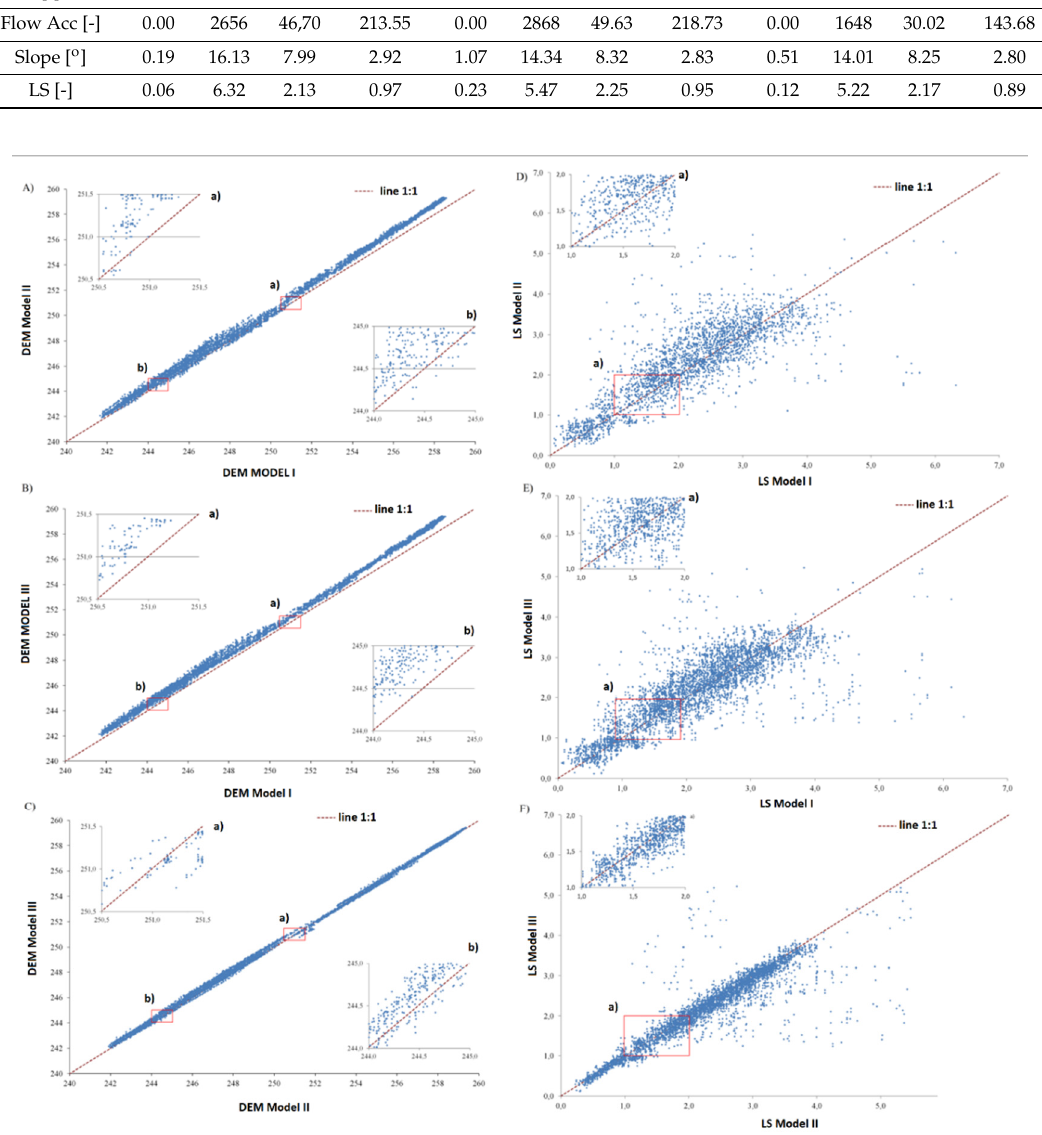
Figure 7. Linear-regression relationship of DEMs ( A – C ) and LS ( D – F ) for the field data with AP (Model I), ALS (Model II), and TLS (Model III) methods.